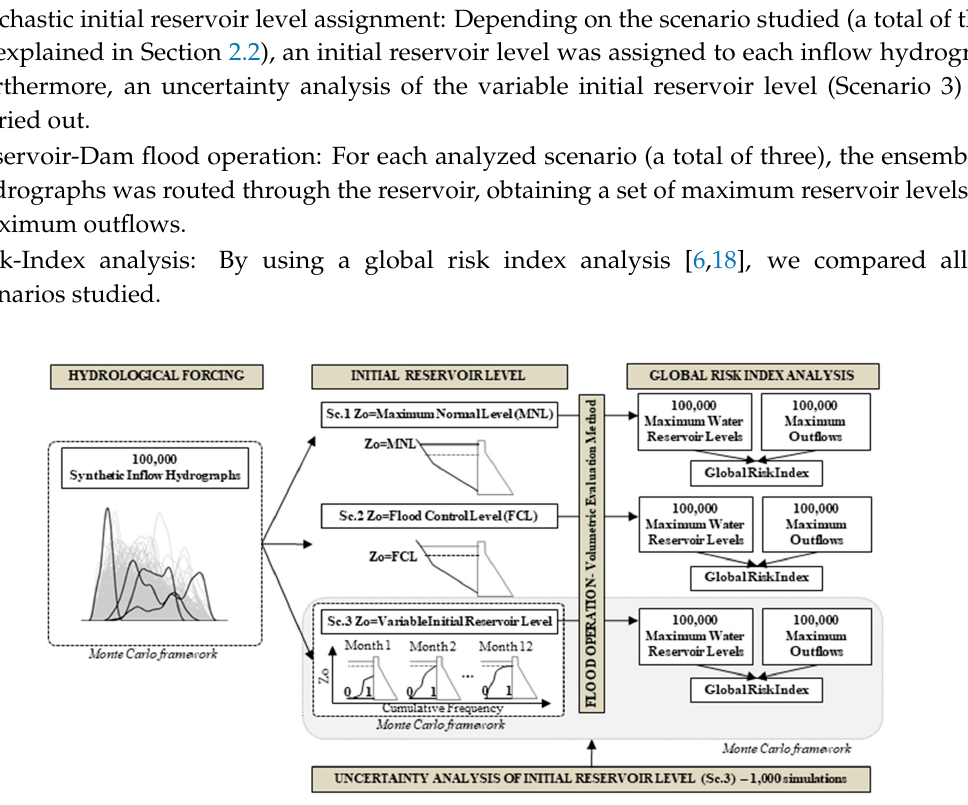
Figure 1. General scheme of the methodological approach. Sc. 1, Sc. 2, and Sc. 3 stand for the three different scenarios of initial reservoir level (Zo) studied.